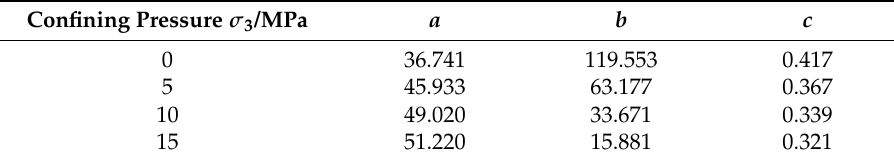
Table 2. Fitting coefficients for Equation (12) under different confining pressures.